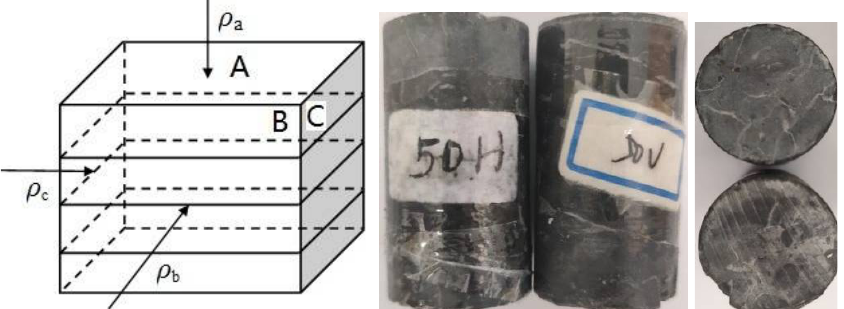
Figure 10. Schematic diagram of resistivity measurement orientation of rock sample and physical drawing of coring rock sample.